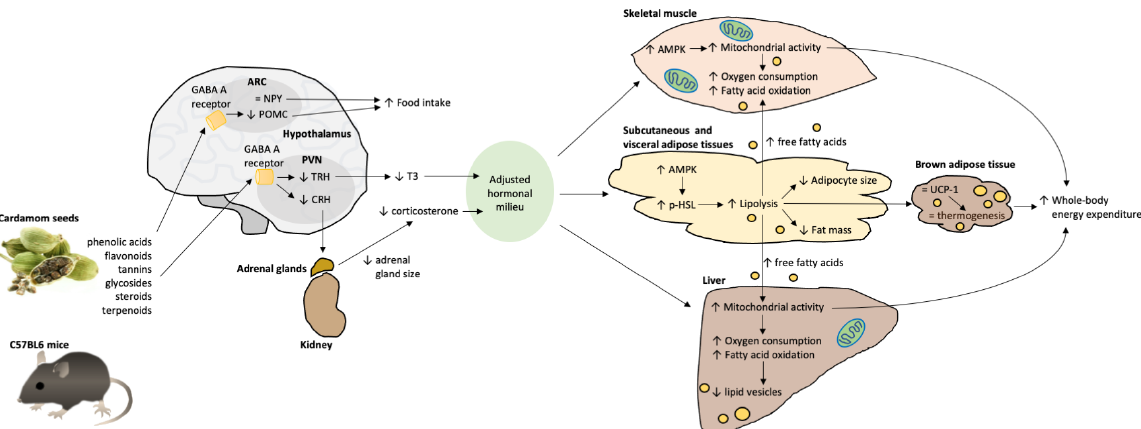
Figure 9. Scenario 2: Modulation of the thyroid and adrenal axes by cardamom intake, generating an “adjusted hormonal milieu” with peripheral effects regulating energy metabolism. Cardamom seed consumption modulates the expression of NPY and POMC, the hypothalamic peptides controlling food intake and energy expenditure, probably by activation of the GABA A receptor in the arcuate nucleus (ARC). Furthermore, activation of the GABA A receptor in the paraventricular nucleus (PVN) influences TRH and CRH neurons which regulates the synthesis and secretion of triiodothyronine (T 3 ) and corticosterone. The metabolic activities of T 3 in peripheral tissues includes the stimulation of lipolysis in adipose tissue through activation of hormone sensitive lipase (HSL), the activation of uncoupling protein 1 (UCP-1) mediated thermogenesis in brown adipose tissue, and the stim- ulation of oxidative capacity in liver and skeletal muscle by increasing mitochondrial biogenesis and activity, in part by increasing AMP-activated protein kinase (AMPK). Conversely, corticosterone down-regulates some metabolic pathways that are activated by T 3 . Thus, the modulation of PVN activity mediated by cardamom intake could reduce T 3 secretion but also corticosterone synthesis, increasing some of the thyroid-mediated metabolic actions in peripheral tissues. The regulation of the hypothalamic-pituitary-thyroid (HPT) and hypothalamic-pituitary-adrenal (HPA) axes by cardamom intake generates an “adjusted hormonal milieu”, reducing body fat by increased lipolysis and in- creasing oxygen consumption and energy expenditure through augmented mitochondrial activity in skeletal muscle and liver. Upwards arrow = upregulation, downwards arrow =